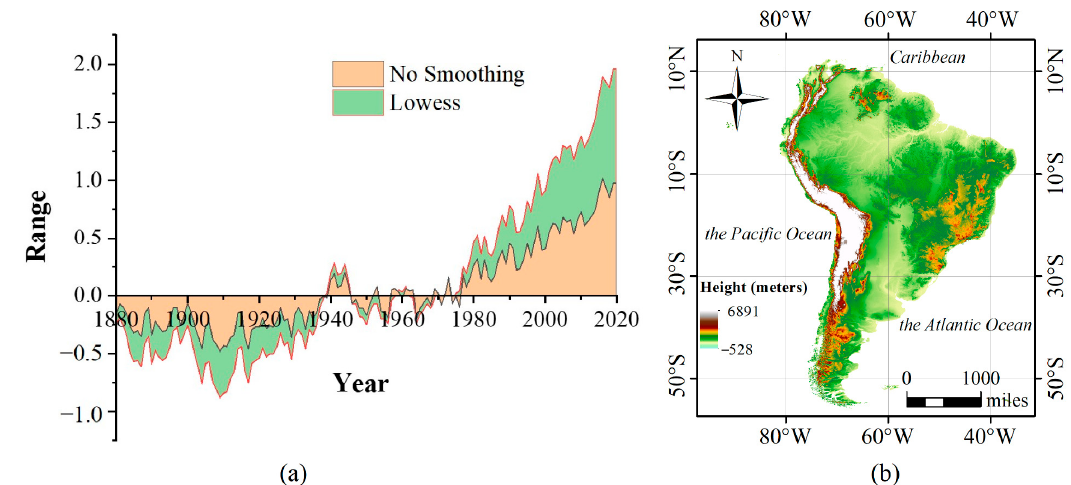
Figure 1. ( a ) Global temperature anomalies from 1880 to 2019. The temperature anomaly is the difference between the average annual temperature since 1980 and the average from 1951–1980. The orange represents data without smoothing, and the green represents data smoothed using the LOWESS (locally weighted scatterplot smoothing) method ( b ) Geographical region of South America. The background is an SRTM digital elevation model (DEM) with a spatial resolution of 250 m. South America is composed of 13 countries with longitudes ranging from 34 ◦ 46 (cid:48)